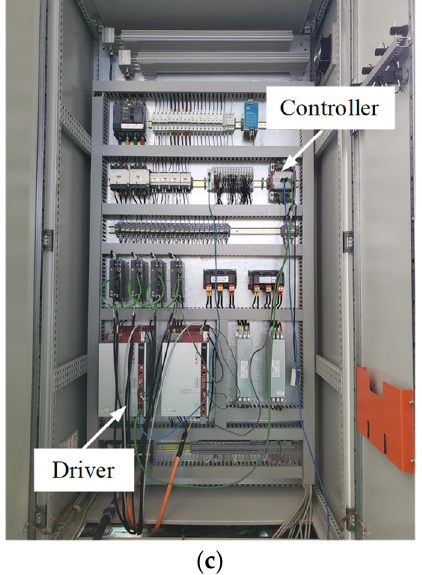
Figure 7. Experimental platform for energy transfer research of the EHSPCS: ( a ) Lithium battery rolling machine; ( b ) EHSPCS unit; ( c ) Power cabinet.